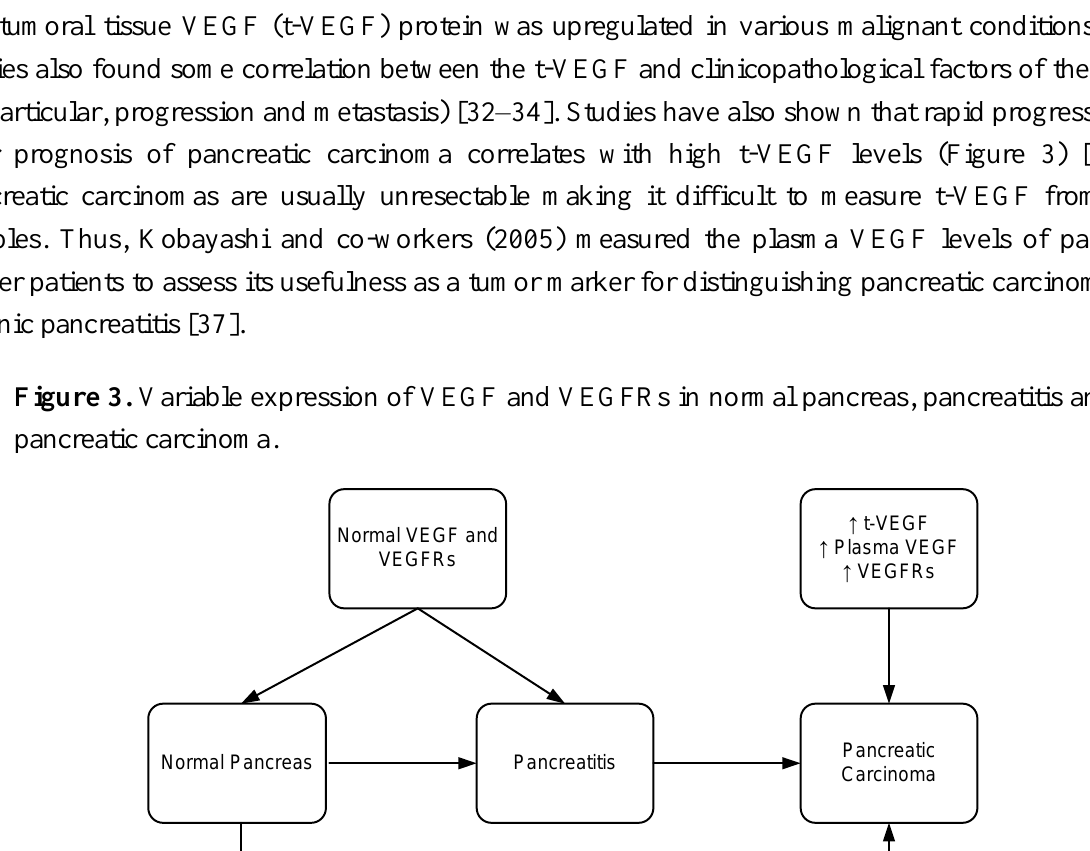
(Figure 2). Two tyrosine kinase receptors with high affinities for VEGF have been identified: VEGFR1 [fms-like tyrosine kinase 1 (flt-1)] and VEGFR-2 [fetal liver kinase 1 (flk-1) is the murine homologue]. VEGFR1 and VEGFR2 have an amino acid sequence homology of 44% [38,39]. Binding of VEGF to its receptor causes autophosphorylation of the receptor and subsequent signaling cascade activation [40,41]. Flk-1, murine homologue of VEGFR2, has 85% sequence homology with human KDR (Kinase insert domain receptor)